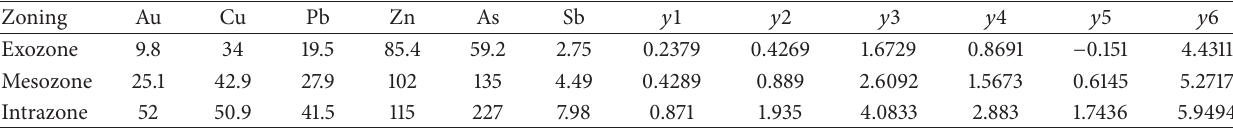
Table 4: Zoning sequences delineated by the cumulative